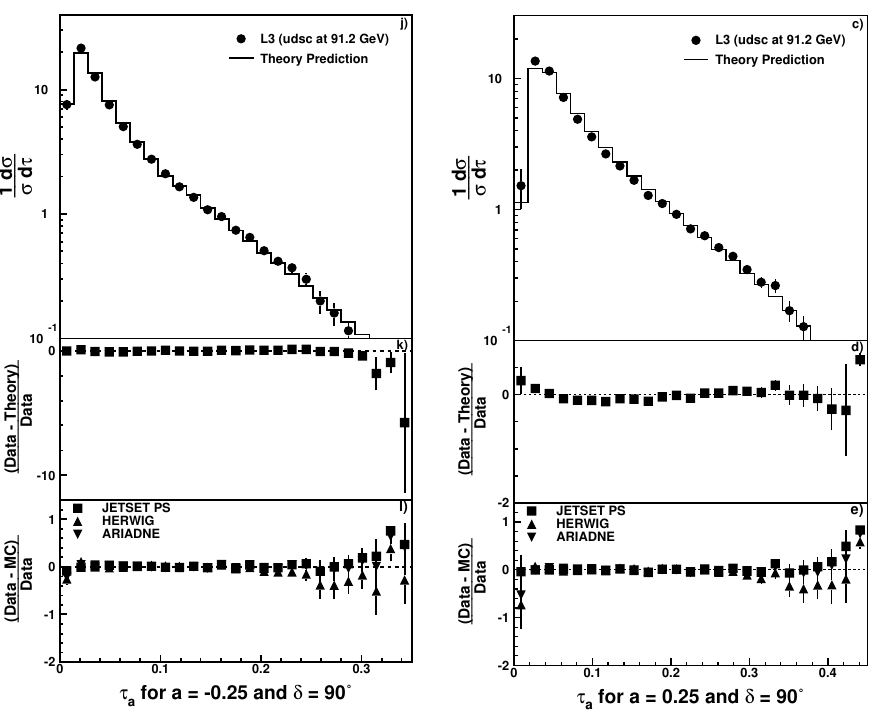
Figure 5 . Corrected inclusive event shape distributions at √ s = 91.2 GeV for udsc-flavour data Figure 2 . Sample data at Q = 91 : 2 GeV from the L3 collaboration [52] for two angularities: samples for a = 1 . 0 (a), 0 . 75 (d), 0 . 5 (g), 0 . 25 (j). These distributions are compared with a = 0 : 25 and a = 0 : 25. The theory predictions in the top panels are based on [40, 41, 53], which (cid:0) − − − − include the prediction of the non-perturbative scaling rule in eq. predictions from the scaling hypothesis. The fractional di ff erences are shown for a = 1 . 0 (b), − 0 . 75 (e), 0 . 5 (h), 0 . 25 (k). Comparisons with predictions from several QCD motivated Monte − − − Carlo programs are shown as fractional di ff erences for a = 1 . 0 (c), 0 . 75 (f), 0 . 5 (i), 0 . 25 (l). − − − − The data points shown here are also tabulated in tables 4, 5, 6, 7.